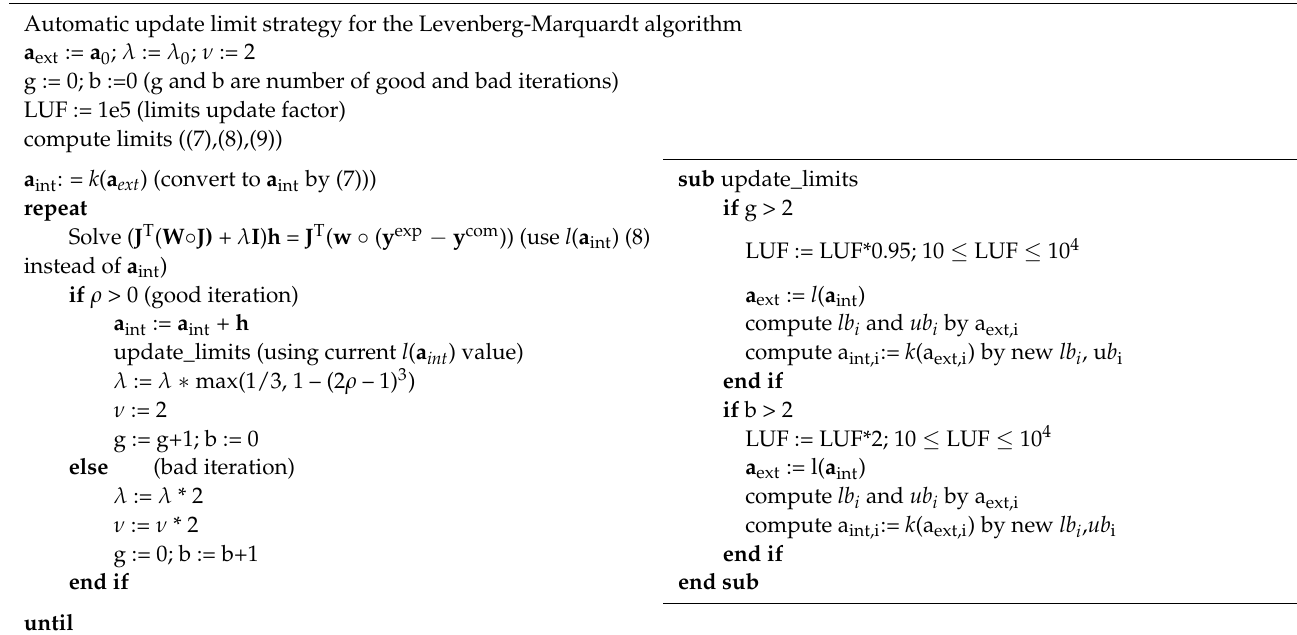
Algorithm 3. Pseudocode of the Levenberg–Marquardt algorithm, which is coupled by the automatic update limit strategy (see sub procedure). Symbol references: J is the Jacobian matrix, J T ( W ◦ J) is the approximate Hessian matrix; I is the identity matrix, J T ( w ◦ ( y exp − y com )) is the gradient vector, w is the vector containing weights (3), and W is the matrix with columns equal to weights (3). Automatic update limit strategy for the Levenberg-Marquardt algorithm